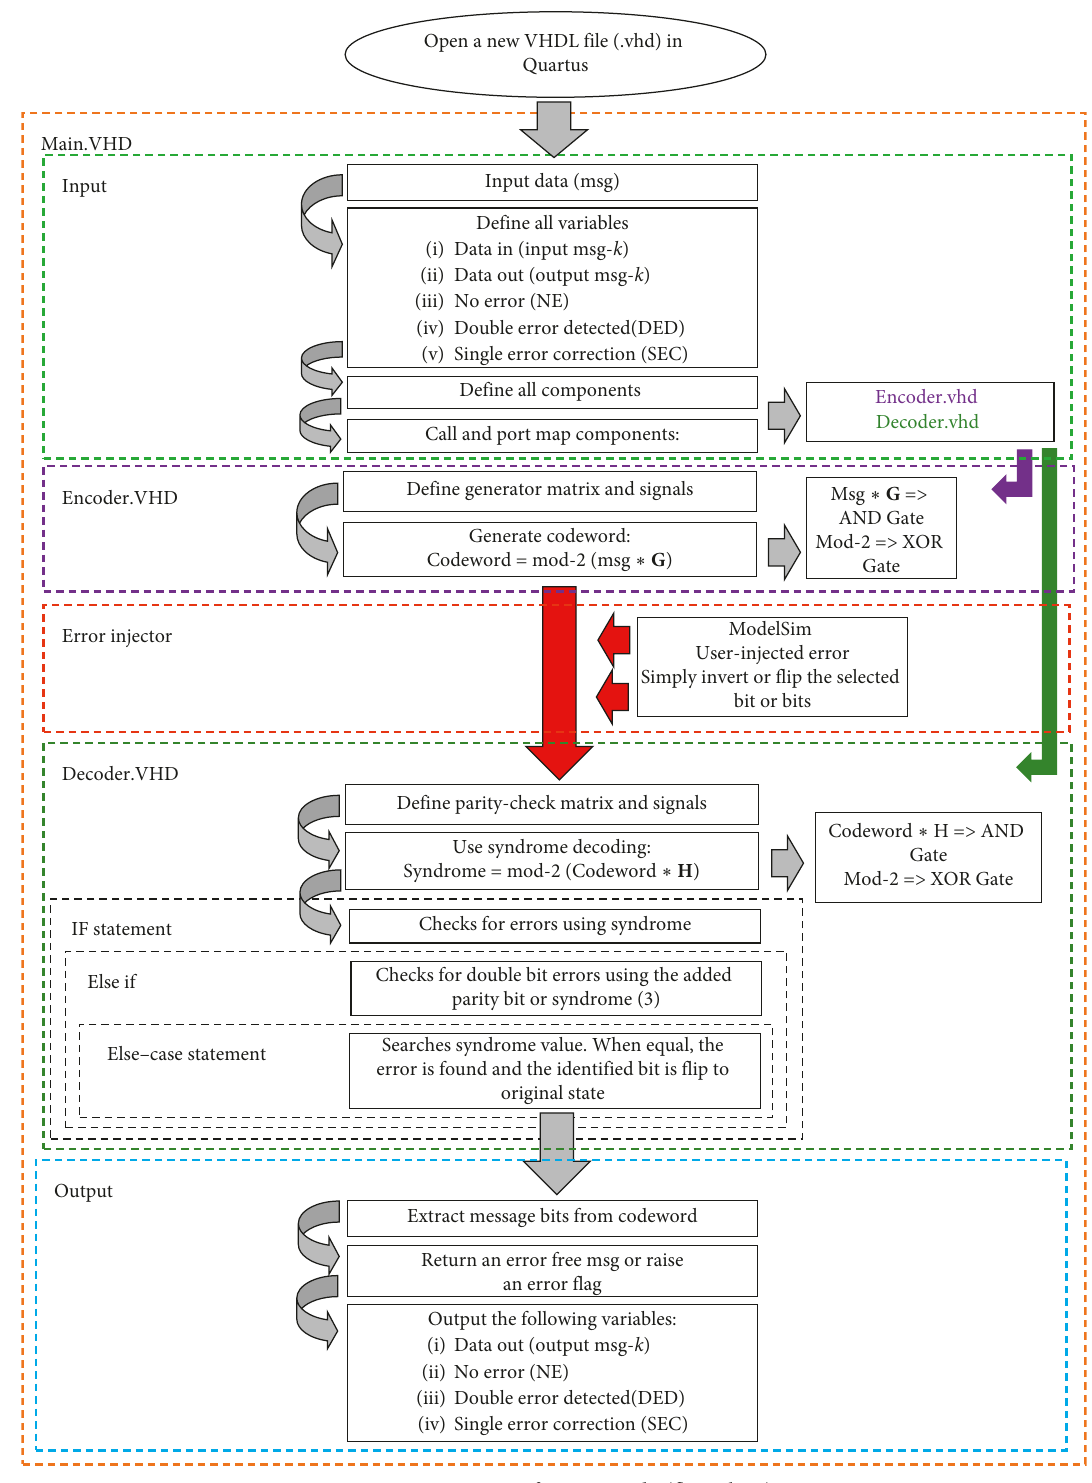
Figure 9: Overview of VHDL code (flow